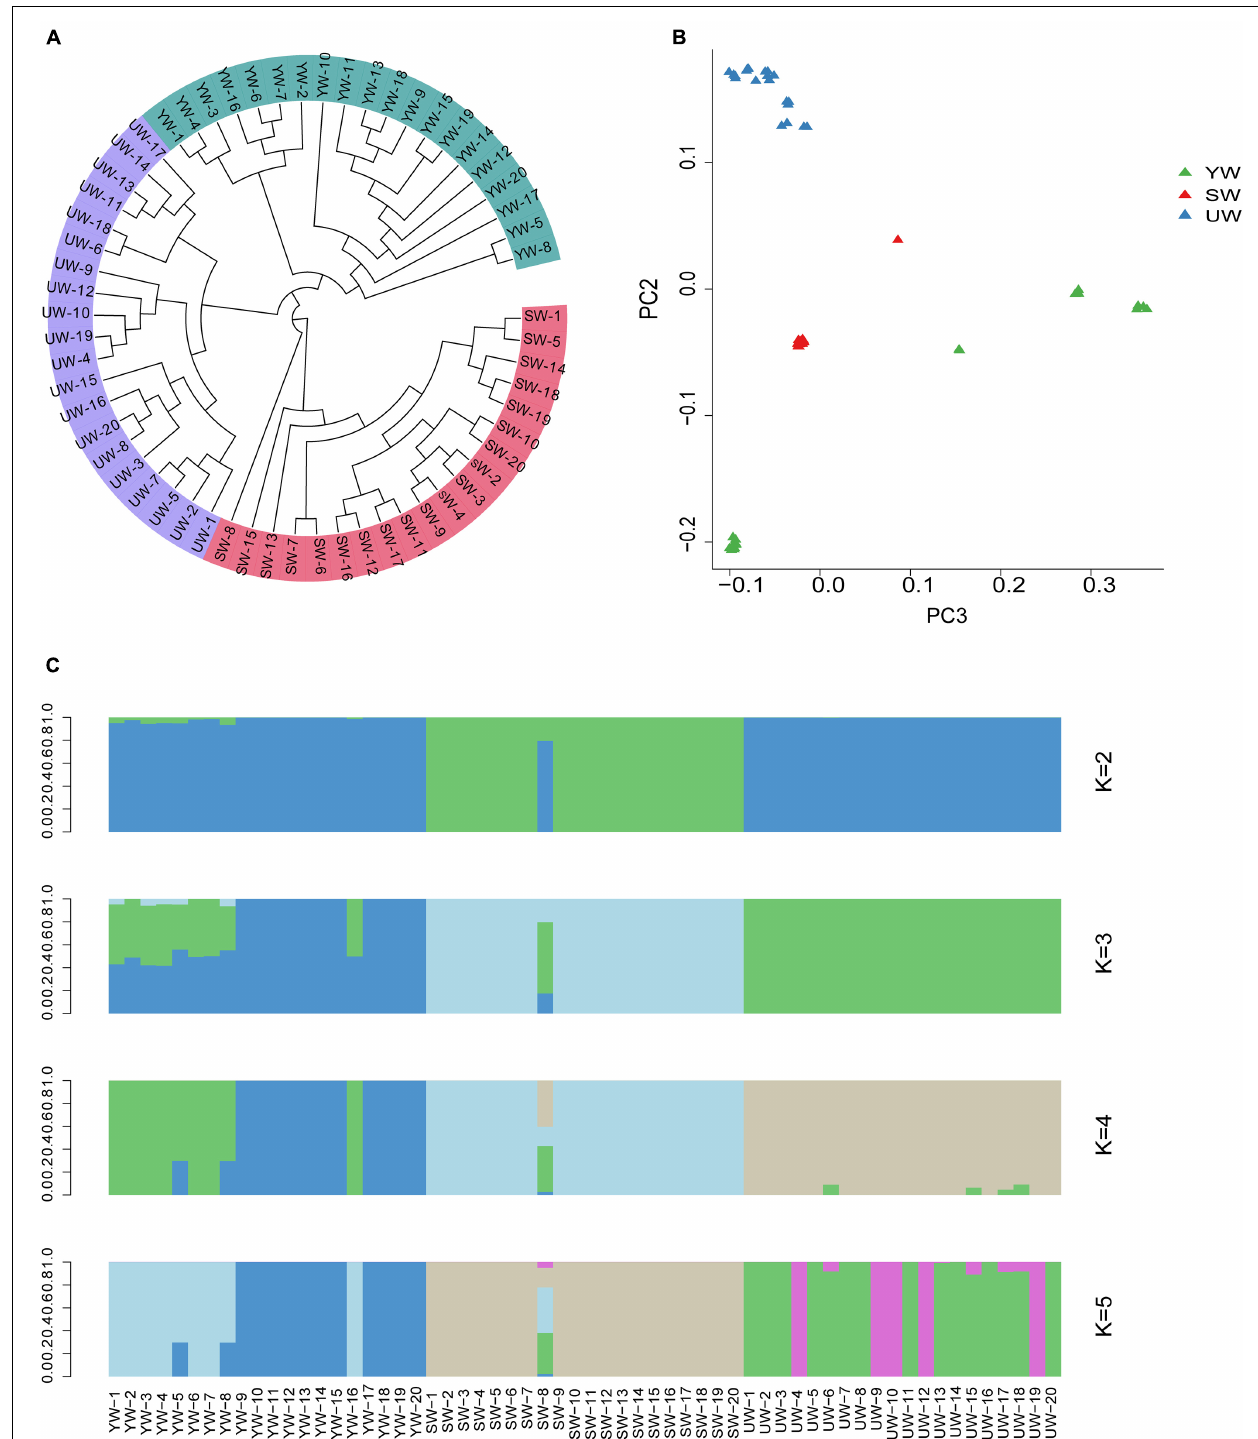
FIGURE 2 | Population structure analysis based on individual SNPs. (A) Phylogenetic tree showing the evolutionary relationships between different populations, the evolutionary branches of more closely related population are grouped together and marked by the same color. (B) Principal component analysis (PCA), which each point in the diagram represents a sample, and samples from the same group are represented in the same color. The closer the distance between the samples, indicates the smaller the genetic background differences between the samples. And vice versa. (C) Population structure analysis, which K values represent the number of different subgroups, and different colors represent different subgroups. Ordinate is the proportion of different subgroups; abscissa is the sample name (UW, SW, YW refers to G. uralensis of eastern, central, and southern regions, respectively, number represents the replicate number).